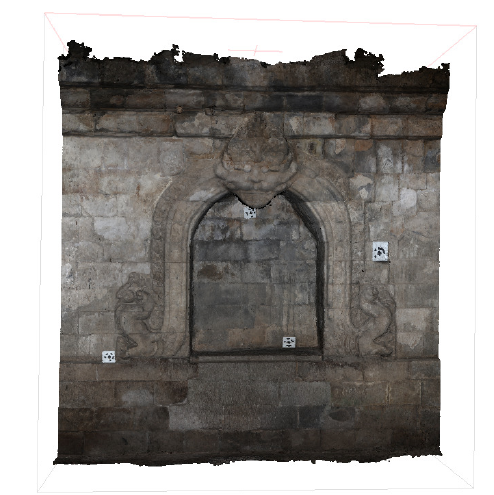
Figure 9. Example of the dense point cloud of the ornate niche in the temple interior